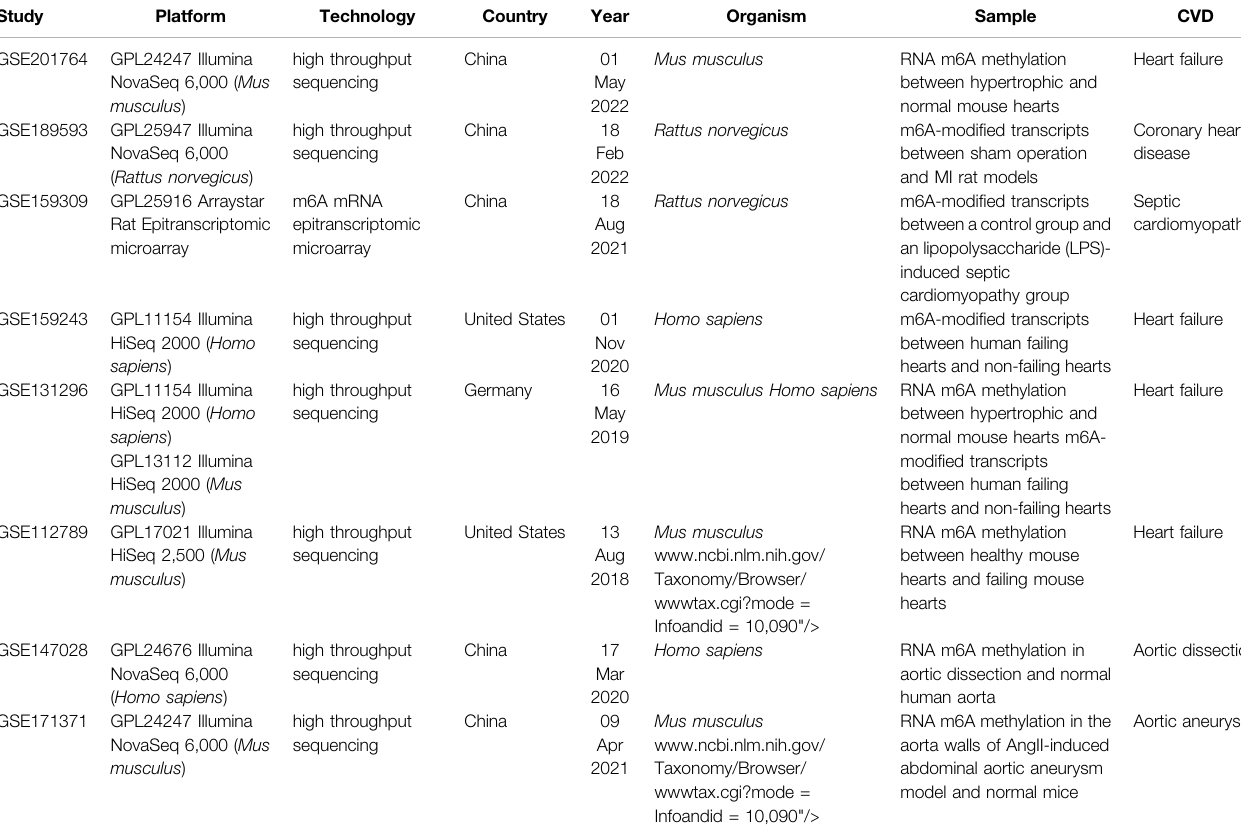
TABLE 2 | m6A sequencing and microarray data in GEO related to